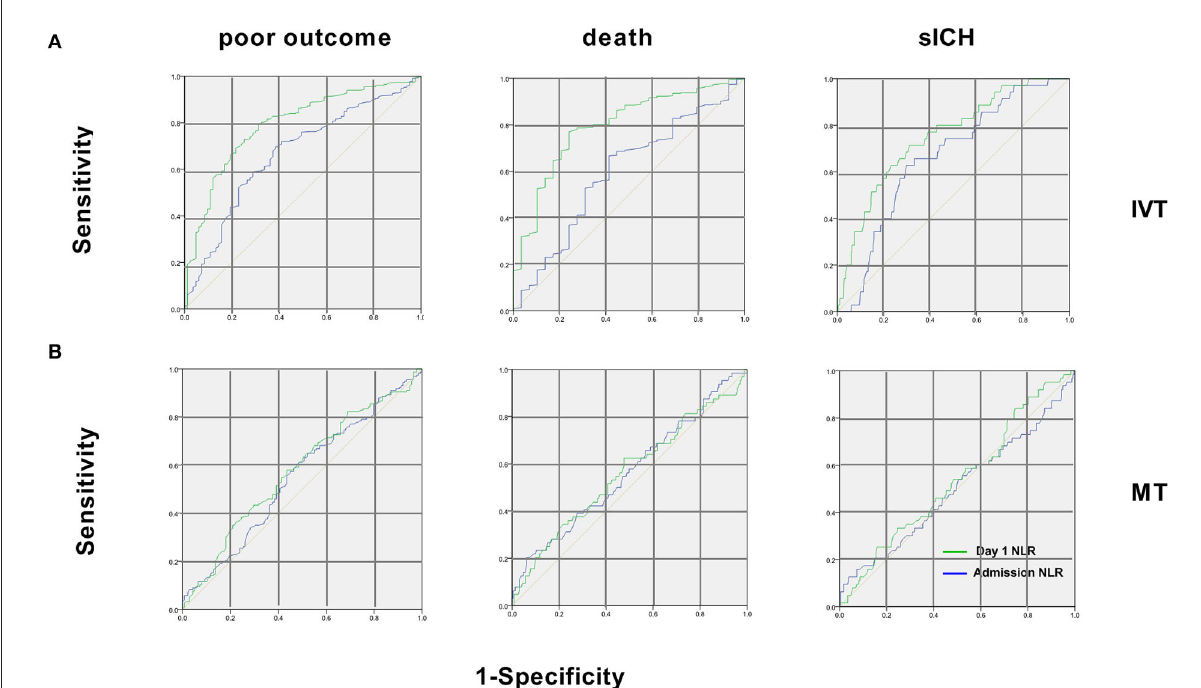
FIGURE3 Receiver operating characteristic curves of NLR for the 3 endpoints in patients with IVT and MT. (A) In patients with IVT, for poor outcome, areas under the curve were 0.66 for admission NLR and 0.78 for day 1 NLR. For 90-day death, areas were 0.60 for admission NLR and 0.81 for day 1 NLR. For sICH, areas were 0.63 for admission NLR and 0.74 for day 1 NLR; (B) In patients with MT, areas under the curve were 0.55 (95% CI 0.48–0.6) for admission NLR and 0.57 (95% CI 0.48–0.66) for day 1 NLR for poor outcome. For 90-day death, areas were 0.57 (95% CI